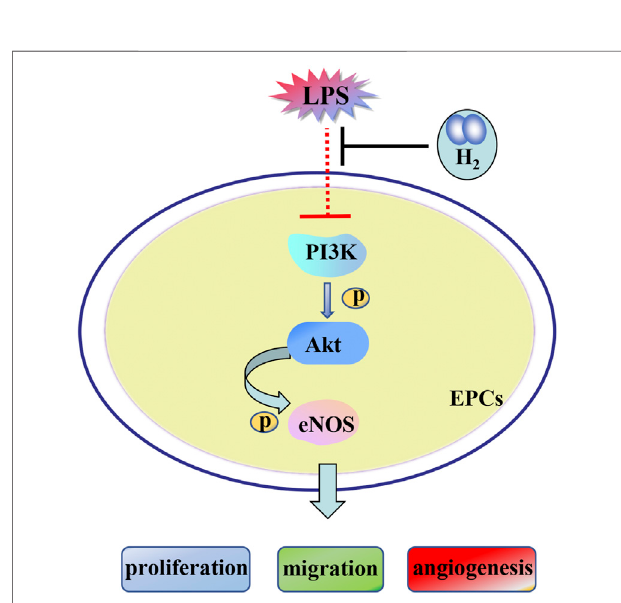
FIGURE 8 | H 2 -mediated restoration of EPCs dysfunctions is mediated by the PI3K/AKT/eNOS pathway.